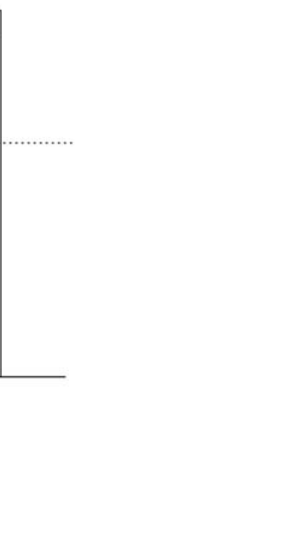
Figure 1. Hydrolyzed casein (HC) preference scores in two-choice tests with species organized in ascending order of magnitude. Scores represent g HC diet consumed/g total (HC + Cel) consumed; 4 d mean 6 SE; asterisks indicate significant difference from indifference (0.5) using a Dunn-Sidak corrected alpha value criterion=0.0051 for 10 comparisons; species that share a letter do not significantly differ from each other based on Tukey’s HSD posthoc tests; blue solid bars are herbivores, open bars are